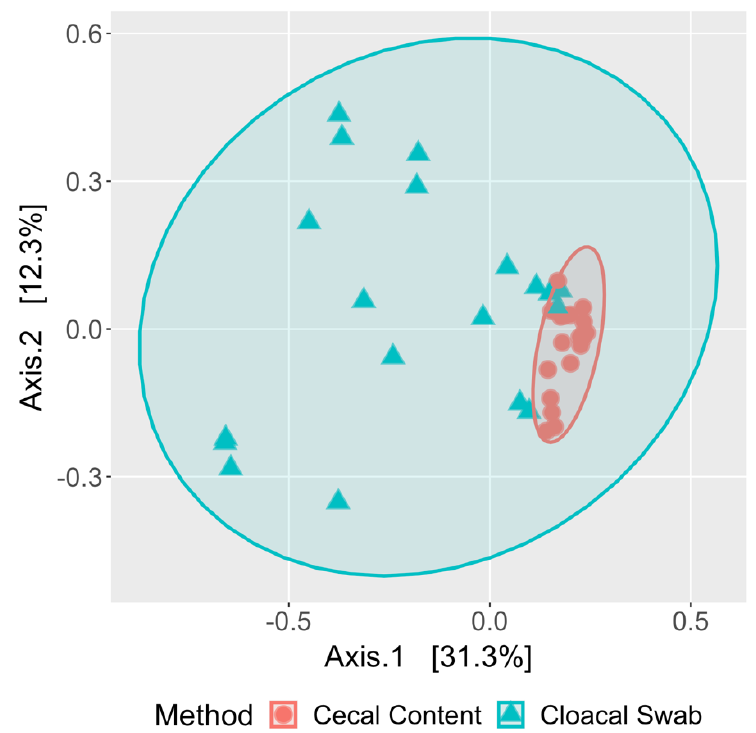
Figure 3. Principal component analysis (PCoA) comparing the cecal content and the cloacal swab testing methods. PCoA plot is based on the Bray–Curtis distances and showed that the cecal samples cluster tightly together, while the cloacal swab samples showed high variability. The ellipses represent the 95% confidence intervals for each sample group.